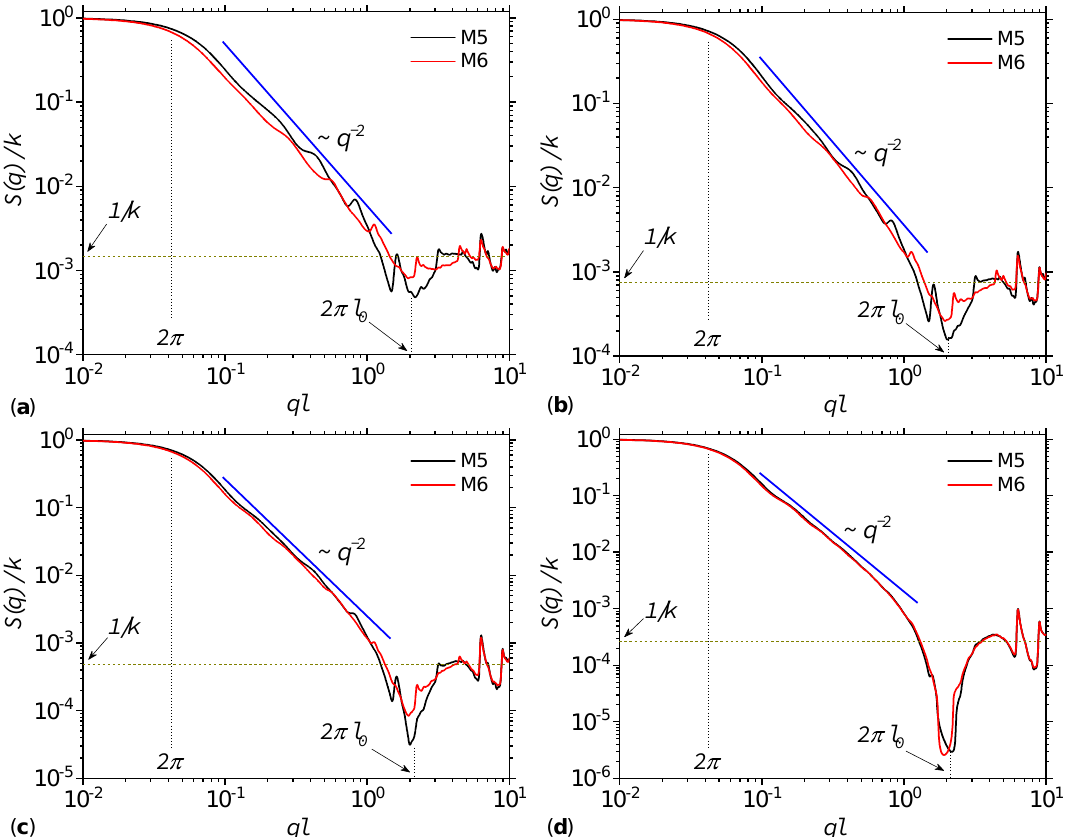
Figure 7. Structure factor (Equation (19)) corresponding to configurations M5 and M6, at various thresholds t . ( a ) t = 0.2. ( b ) t = 0.4. ( c ) t = 0.6. ( d ) t = 0.8. Here, l is the overall size of the fractal in pixels, k is the number of basic units composing the fractal, and l 0 is the pixel